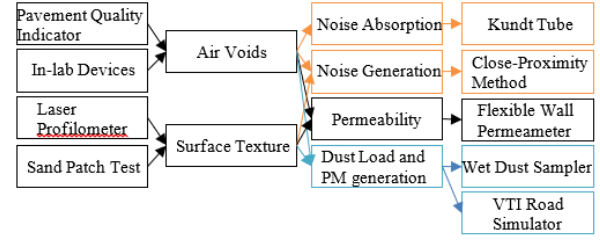
Figure 14: Sensor system, parameter, and performance